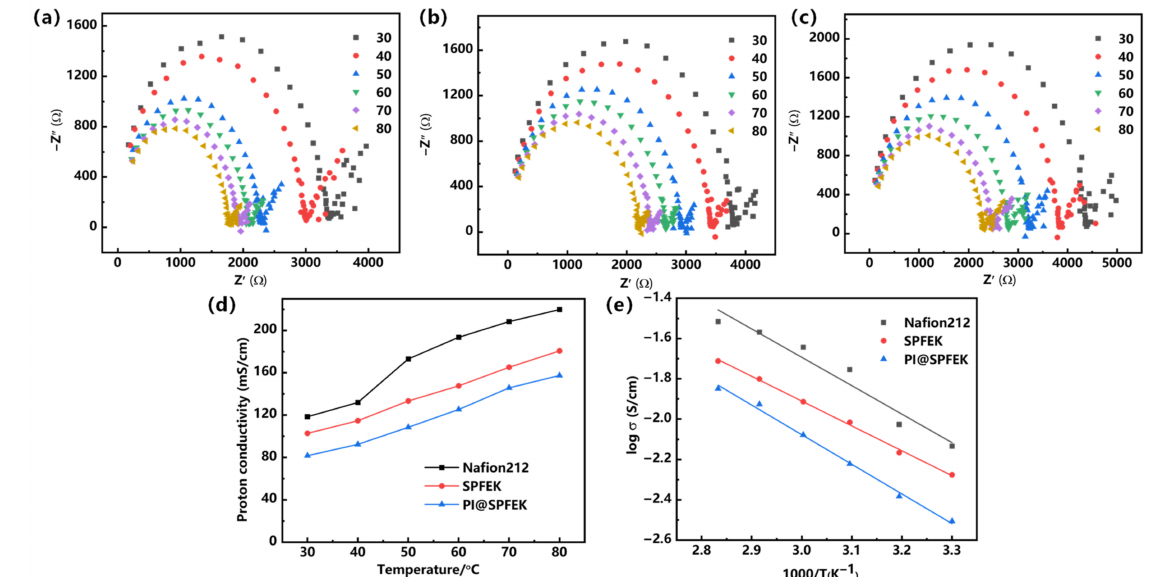
Figure 6. Nyquist plots of ( a ) Nafion 212, ( b ) SPFEK, and ( c ) PI@SPFEK. ( d ) Temperature dependence of proton conductivity of membranes and ( e ) Arrhenius plots of membranes. The cross-sectional area of Nafion 212, SPFEK, and PI@SPFEK